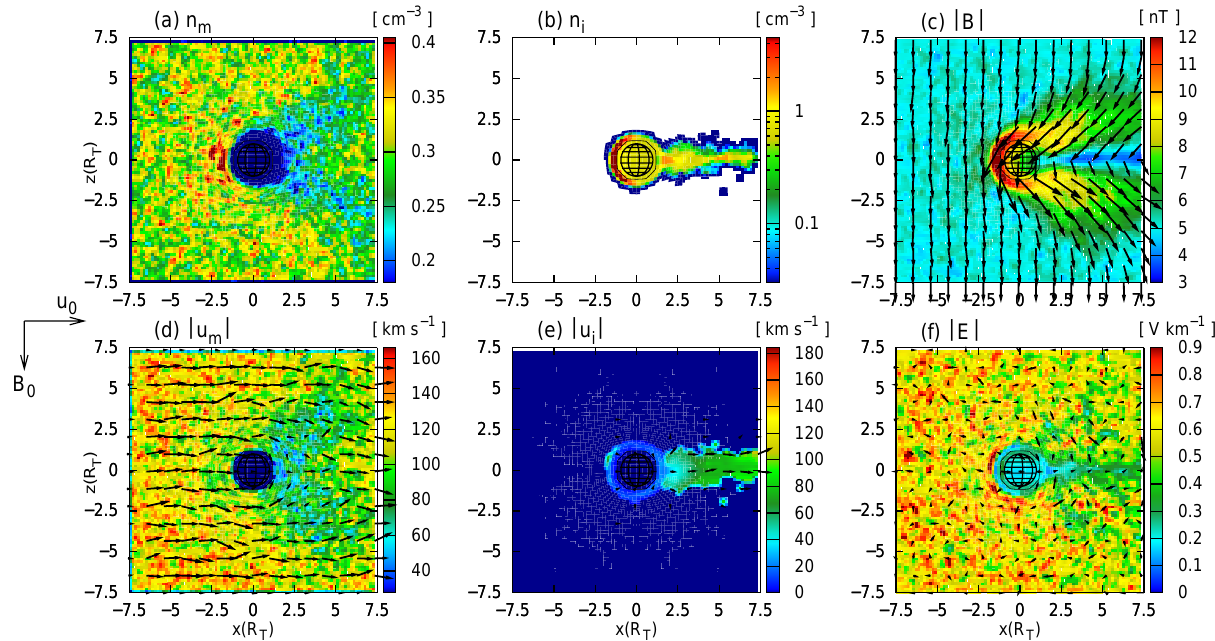
Fig. 10. Interaction of Titan’s ionosphere with the subsonic Saturnian magnetospheric plasma at 18:00 local time. The figure shows a cut through the (x,z) plane which coincides with Titan’s polar plane. The undisturbed plasma velocity points in ( + x) direction; the background magnetic field is antiparallel to the z axis. The figure displays (a) the magnetospheric ion density, (b) the heavy ion density, (c) the magnetic field, (d) the magnetospheric ion velocity, (e) the ionospheric ion velocity and (f) the electric field. In the polar plane, the interaction region exhibits a symmetric structure. As in the case of supersonic plasma flow, the magnetic field exhibits a strong draping pattern, giving rise to a magnetic pile-up region at Titan’s dayside and to two magnetic lobes in the wake region. The region between these lobes is characterized by a significant decrease of magnetic field strength. In contrast to the case of supersonic flow, the magnetospheric plasma is no longer separated from the ionospheric tail by an ion composition boundary. Due to both plasma components contributing to the convective electric field, only a slight reduction of electric field strength occurs in the downstream